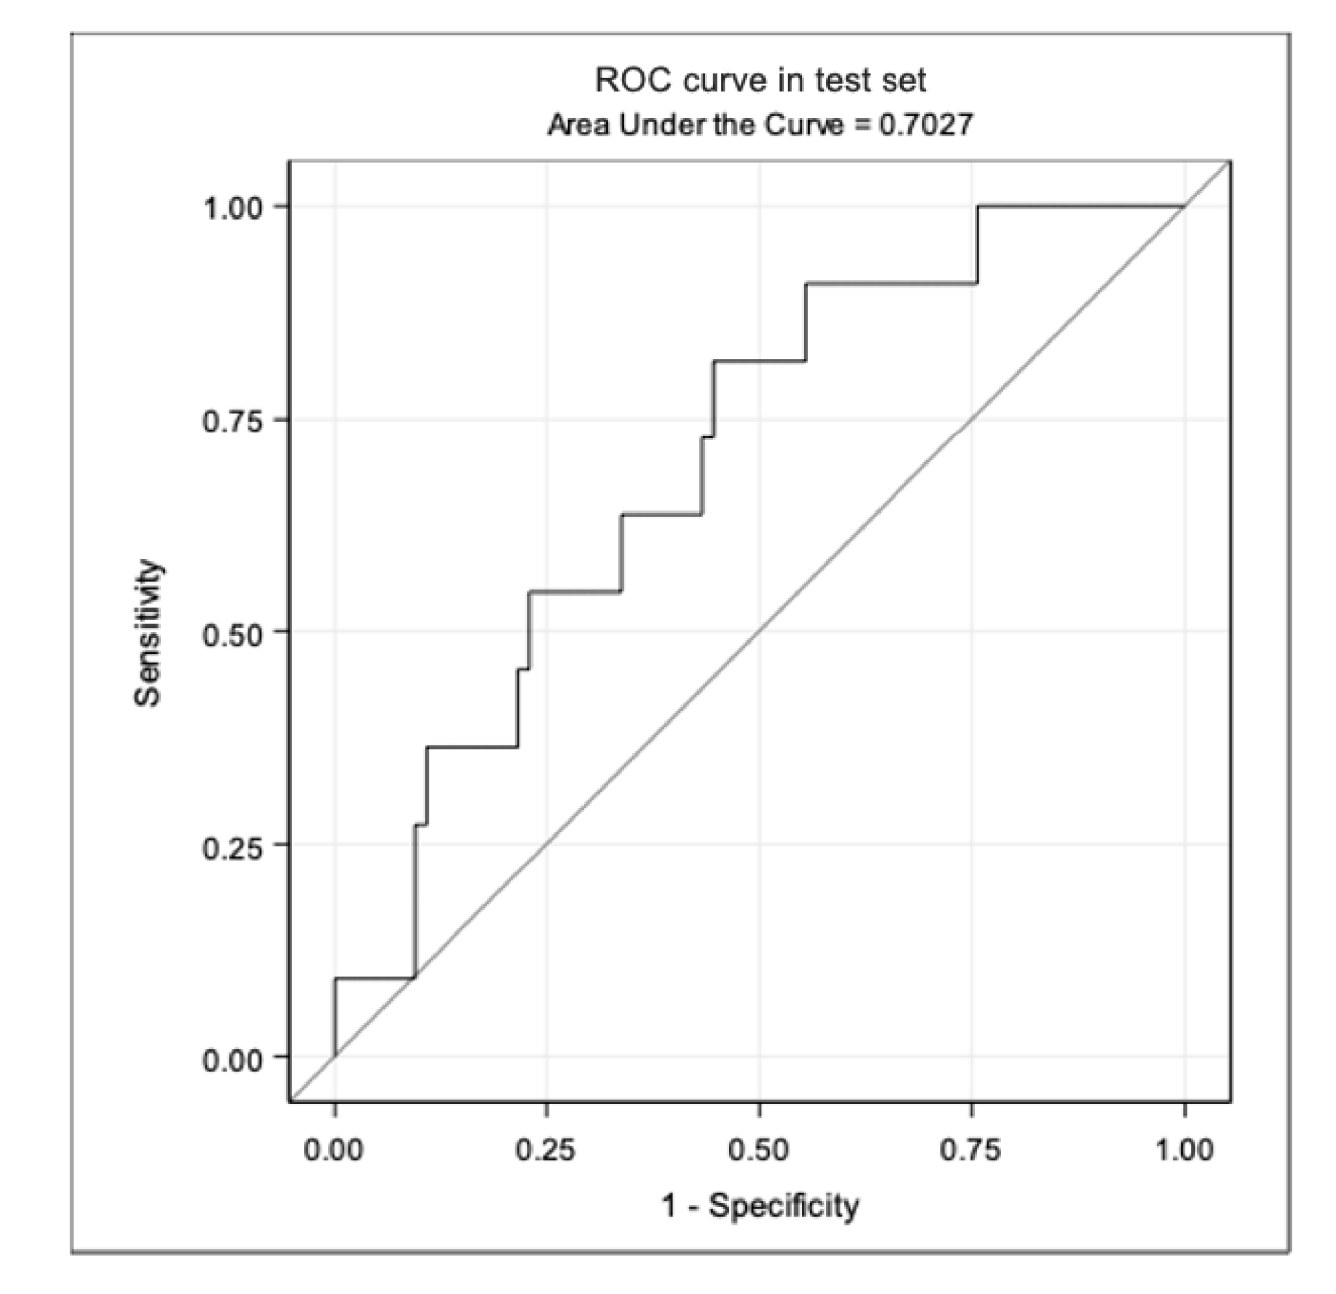
Fig 1. AUC under the ROC analysis—comparison with CV